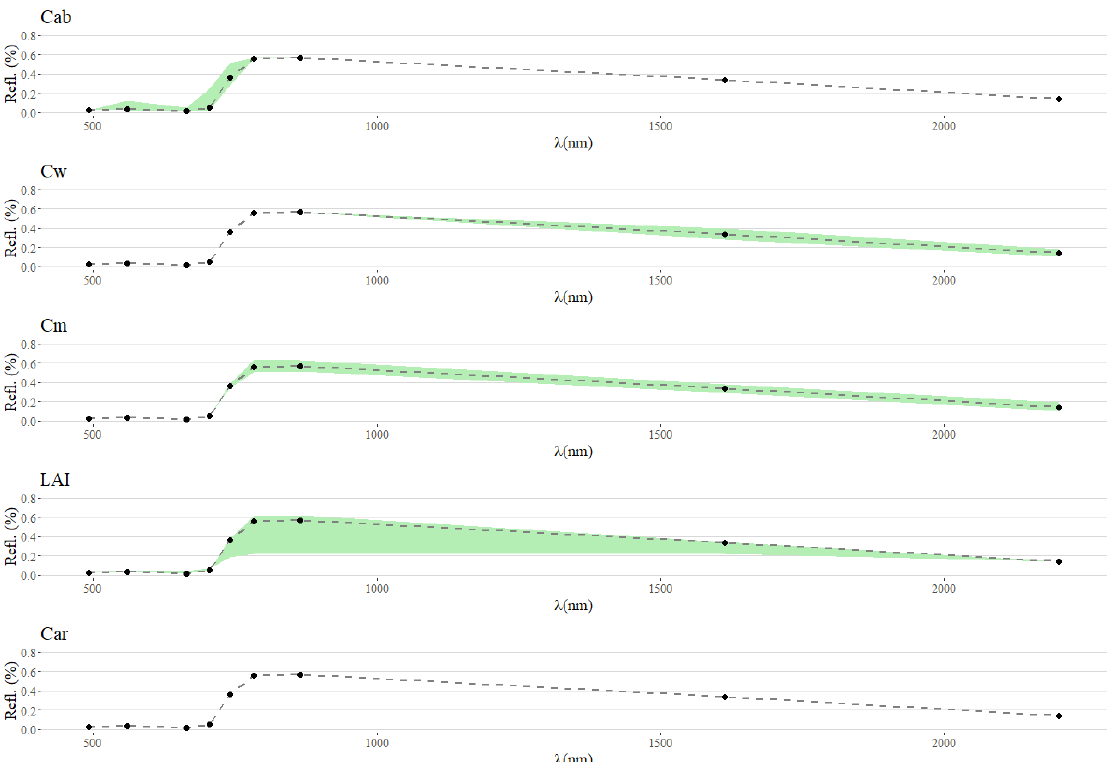
Figure A2. With this figure it is possible to visualize the variation in PROSAIL simulated S2-like data reflectance spectra when stabilizing all traits except for one. This shows that variations in Car are likely not measurable by